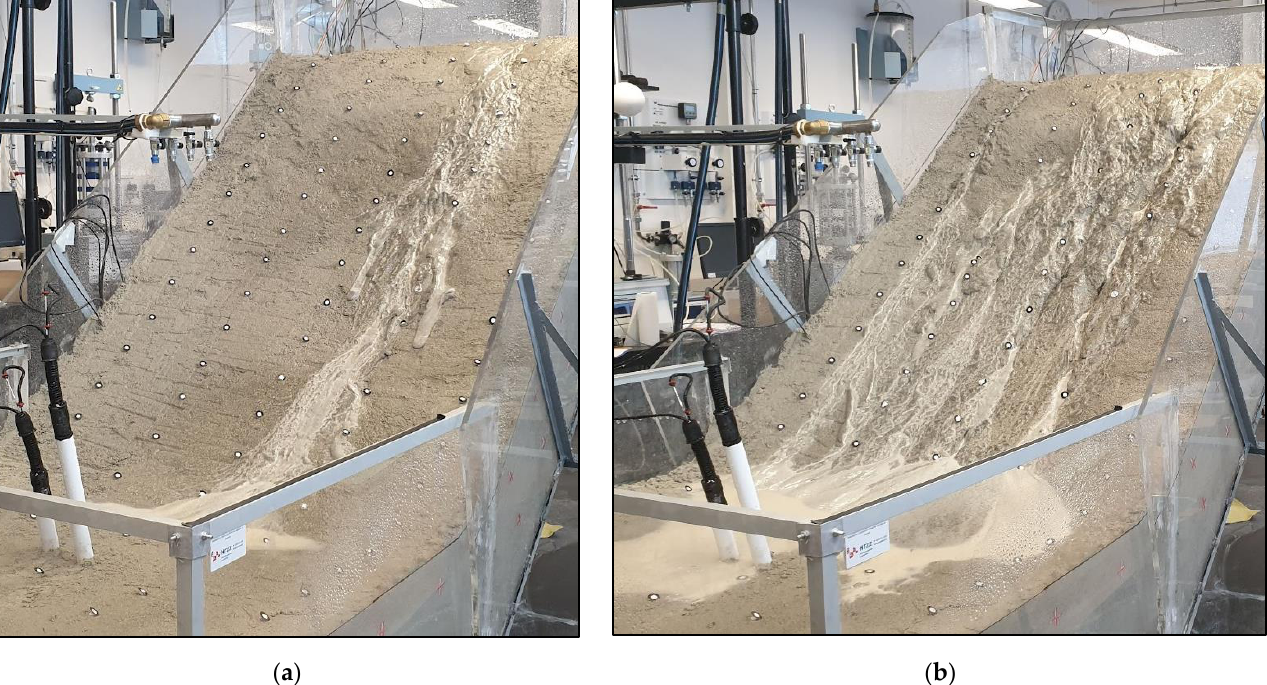
Figure 8. A photo of the SK10er experiment at around 8 ( left ) and 18 ( right ) min after the start of the experiment.